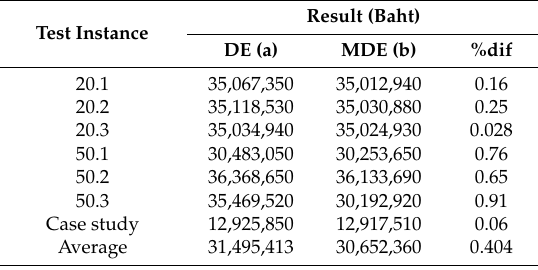
Table 12. Results of seven test instances of DE and MDE using 90 min computational time.